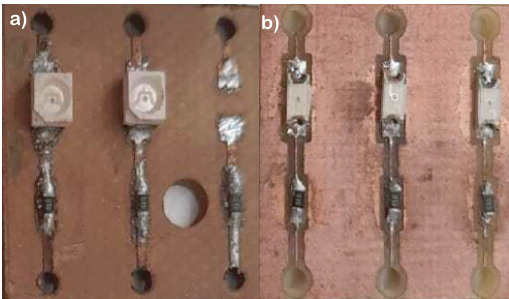
Figure 1. Electronic component assembly. Type Diode-LED. ( a ) shows SnPb Alloy. ( b ) shows SnAg